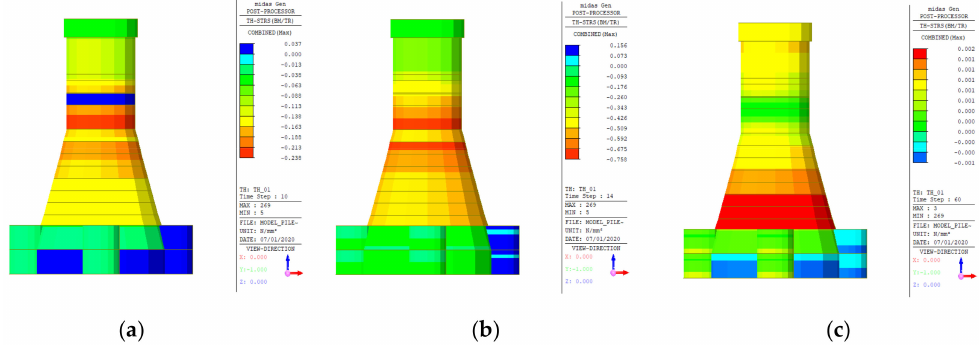
Figure 19. Maximum stresses in the concrete base over time caused by the Pohang earthquake: ( a ) 10 s; ( b ) 14 s; and ( c ) 60